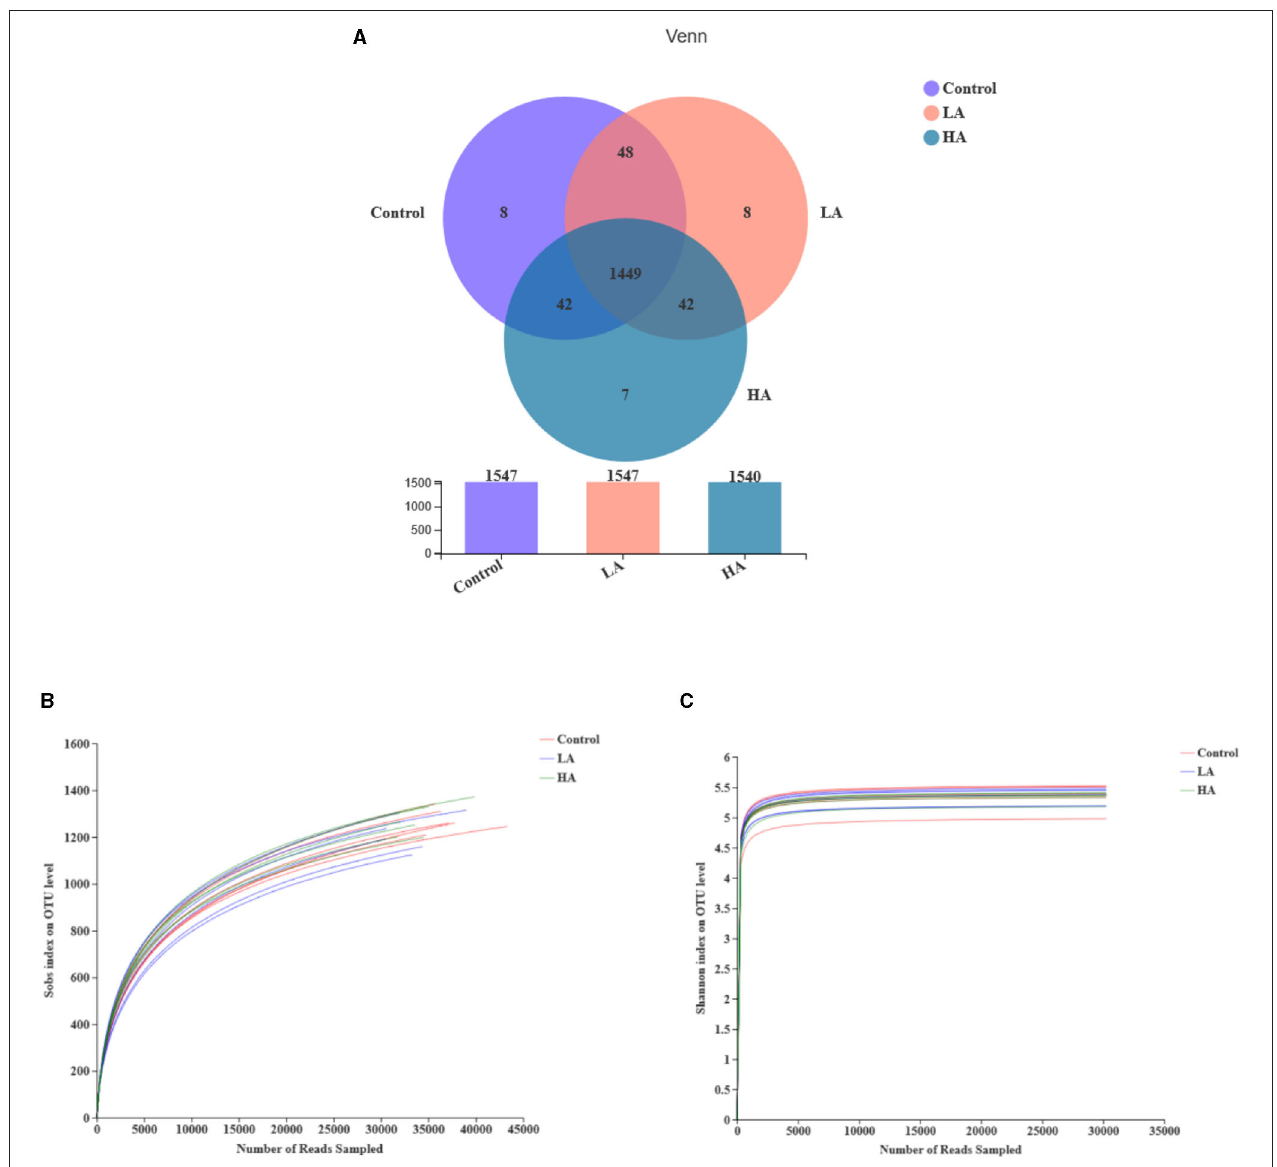
FIGURE 1 | Effect of anthocyanin-rich purple corn on ruminal fluid bacterial diversity. (A) The Venn diagram. (B) The rarefaction curves. (C) The Shannon curves. LA = basal diet + 0.5-g/d PCP; HA = basal diet + 1-g/d PCP.